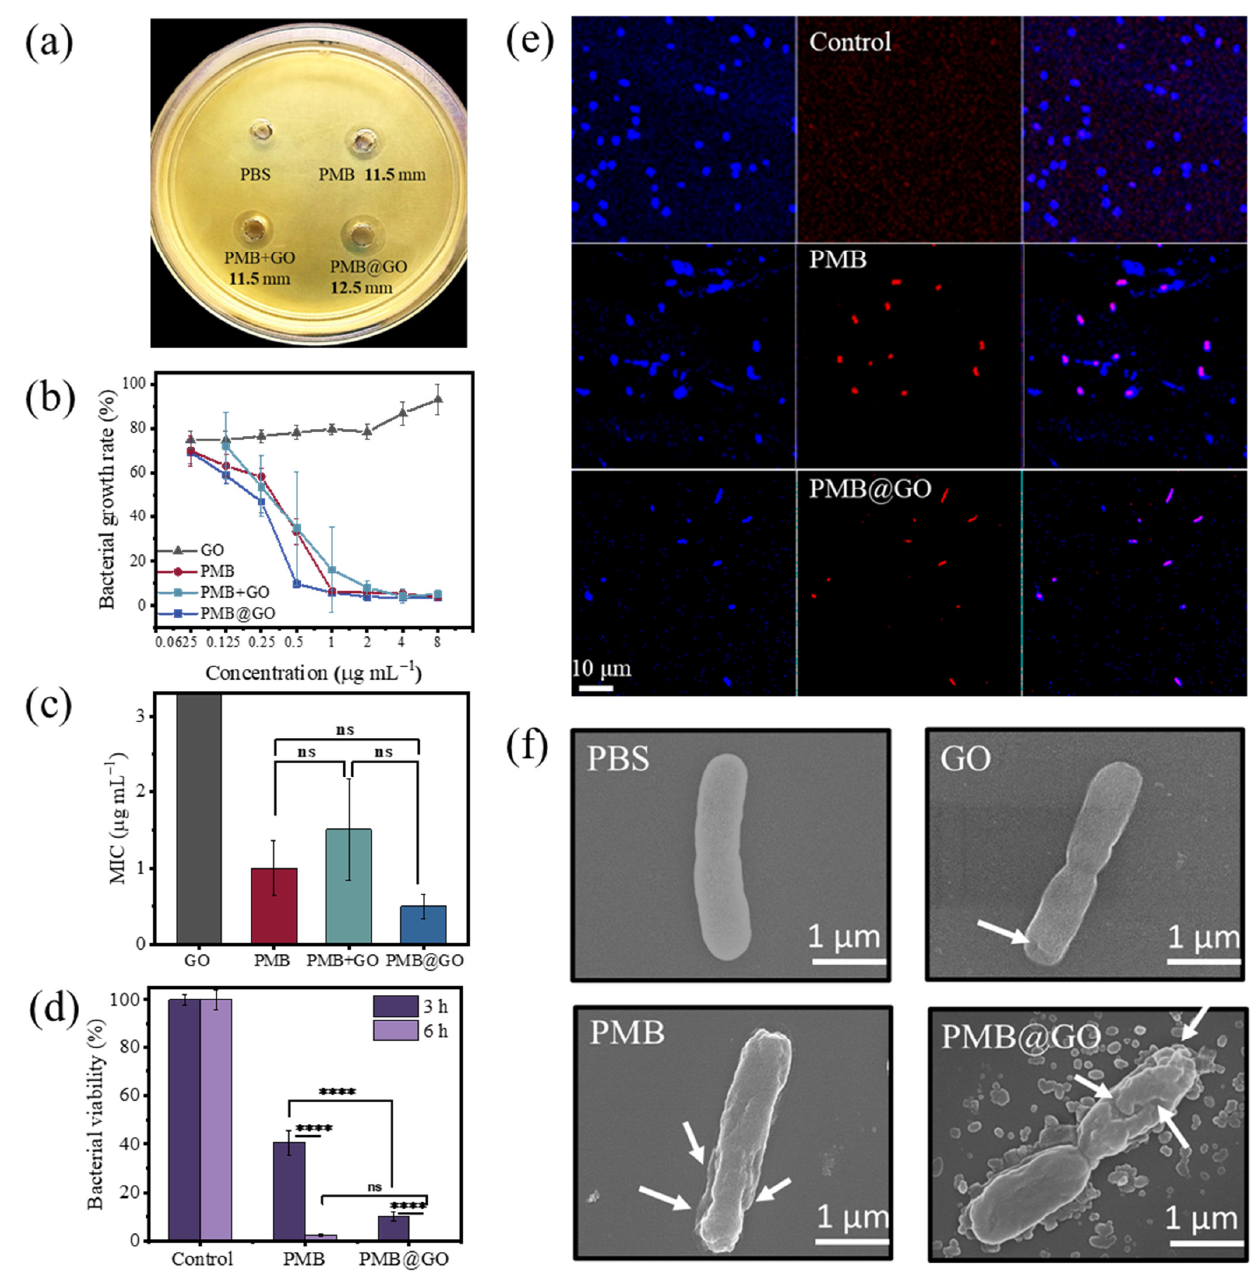
Figure 2. Enhanced antibacterial activity of the PMB@GO nanocomposites. ( a ) Inhibition zones of PMB@GO against E. coli in the agar hole diffusion-inhibition zone method. The assay performed with phosphate buffer solution (PBS) is used as the control. The conditions of free PMB and physical mixture of PMB and GO (i.e., PMB + GO) are also shown for comparison (at 16 μg mL −1 in terms of peptide). ( b , c ) Concentration-dependent bacterial viability ( b ) and MIC determination ( c ) of PMB@GO against E. coli . Free PMB, GO, and PMB + GO are shown as the control. p -values were calculated by t-test and ANOVA (ns means p > 0.05). ( d ) Proliferation capacity of E. coli after treatment with PMB and PMB@GO for 3 h or 6 h, respectively, with PBS as the control. p -values were calculated by t-test and ANOVA (**** p < 0.0001). ( e , f ) LIVE/DEAD staining ( e ) and SEM ( f ) images of microorganisms after treatment with PMB or PMB@GO at their 5 × MIC concentrations for 3 h. In ( e ), all bacteria: blue, dead bacteria: red, scale bar: 10 μm. White arrows in ( f ) representatively show the areas of heavy damage. PBS and GO (at 5 µ g mL − 1 ) are used as the control. E. coli was used as the test microorganism in these